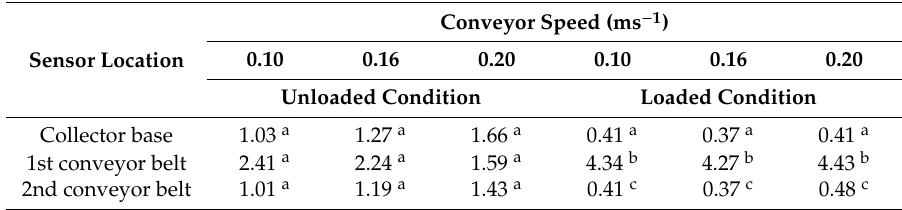
Table 4. Vector sum of the measured vibration on different locations of the radish collector for different conveyor speeds and load conditions.